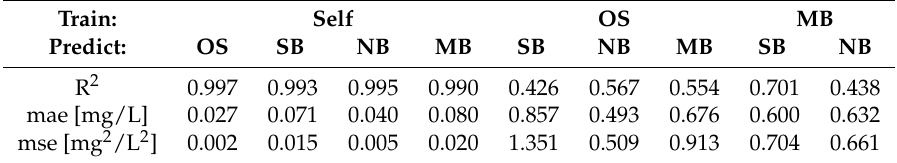
Table 4. Station-based random forest regression (RFR) error predictions, where the top row shows training the nearshore site used for training and bottom row the nearshore site that is